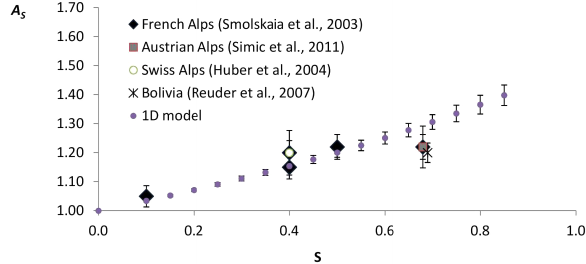
Figure 5. UV amplification due to the surface albedo increase in mountainous areas according to different experimental data and model simulations. The error bars of model simulation relate to the different input parameters – altitude of 2 and 3km, solar ele- vation of 10, 30 and 50 ◦ , total ozone X = 350DU, AOD 340 = 0 . 17 at P =